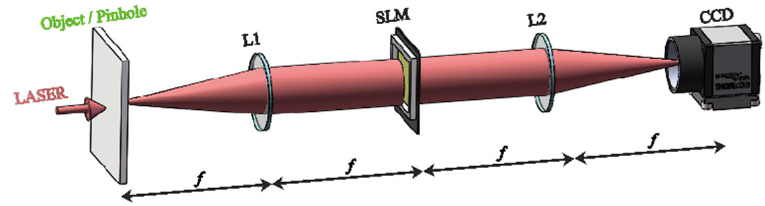
Figure 1. Optical configuration of I ‐ COACH in coherent imaging system.